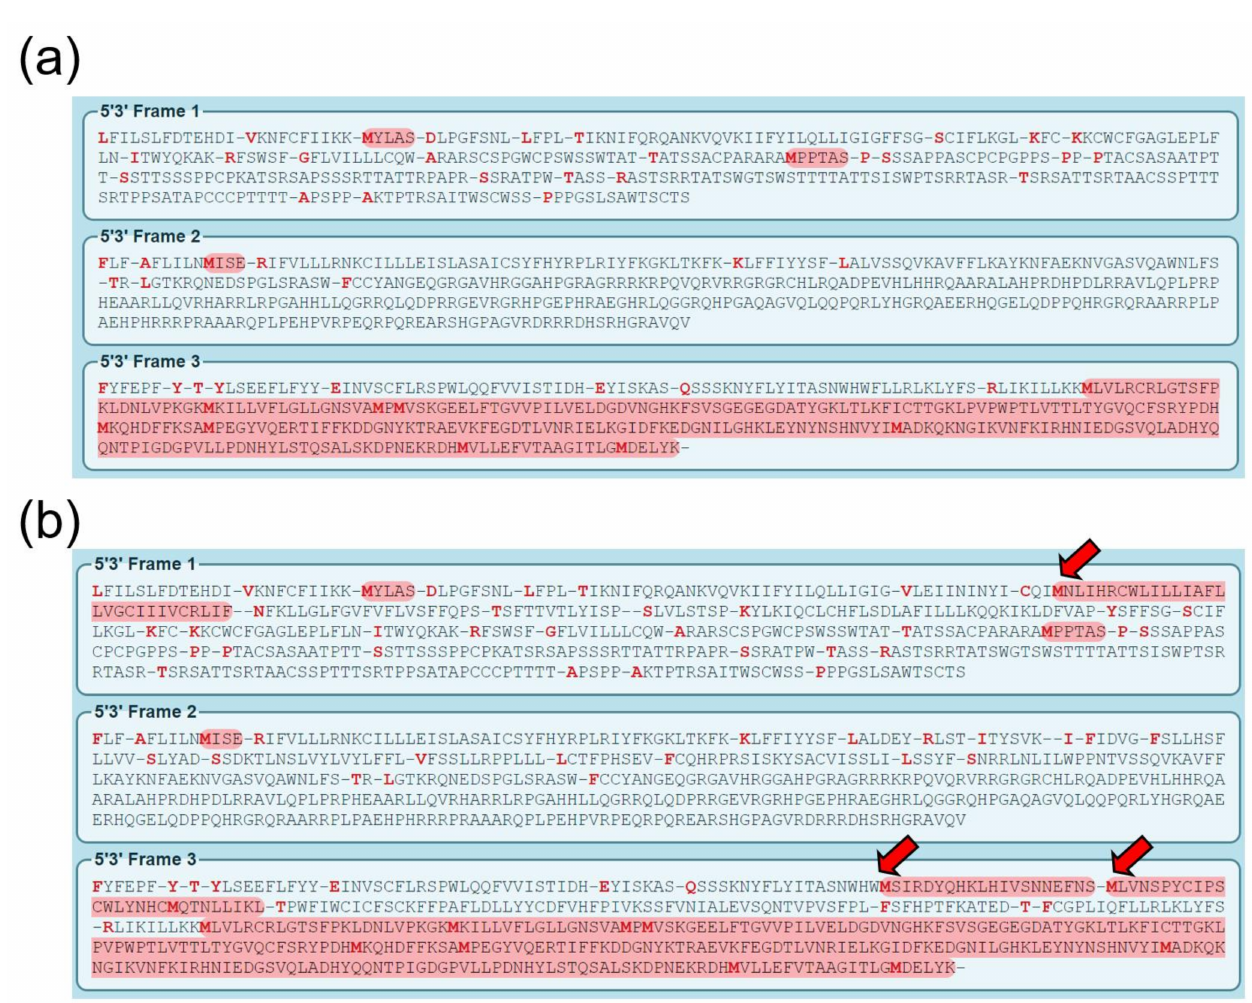
Figure 5. Translation prediction of the wild-type ( a ) and mutant ( b ) mRNA. Reading frame 3 is used in the wild-type. Mutant mRNA was predicted to have one out-of-frame and two in-frame upstream open reading frames (denoted by red